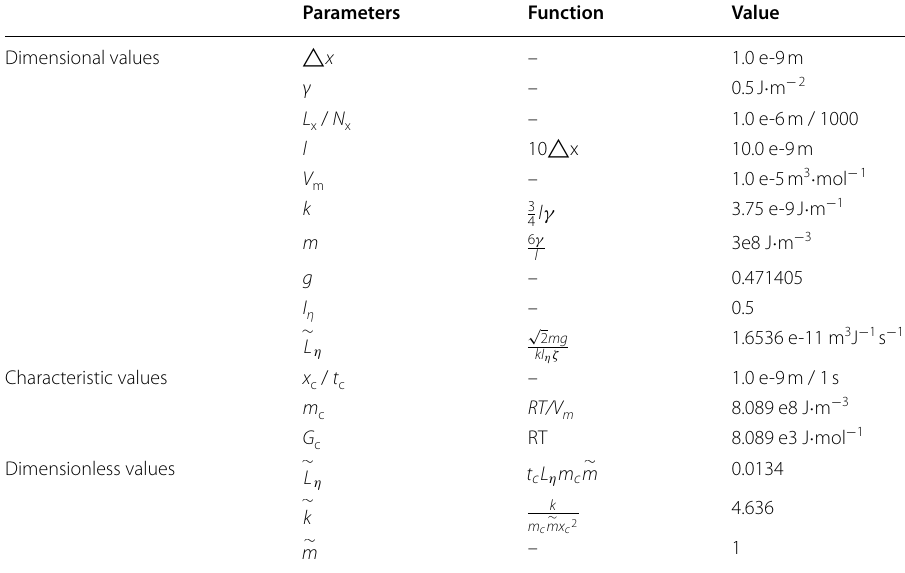
Table 1 Parameters used in the 1-D PF